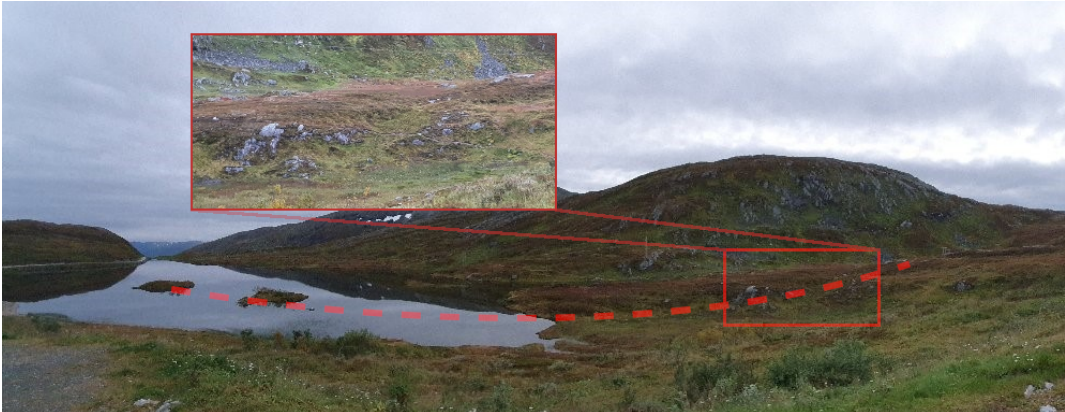
Figure 8. Transect containing rocky parts after melt season. Dotted lines indicate the transect. The cropped-out section show the rocky area where diffraction hyperbolas were found.